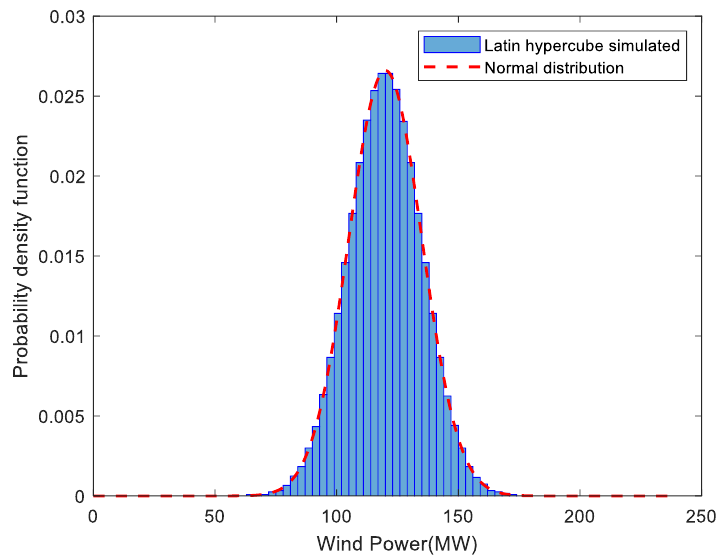
Figure 2. Sample points generated by the Latin hypercube method.